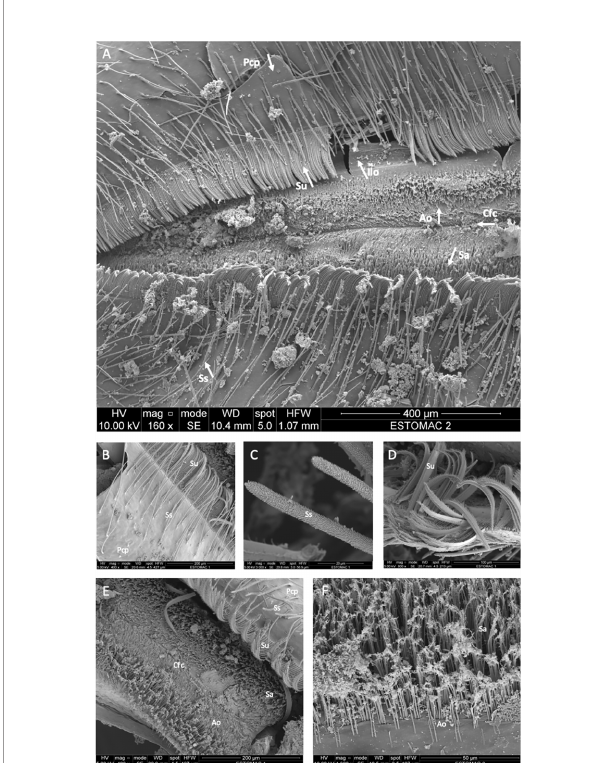
FIGURE 3 | Structure of the cardiac fl oor of a R. exoculata adult observed with scanning electon microscopy. (A) Dorsal view of the cardiac fl oor sieve showing the different ossicles and setae (scale bar = 400 µm). (B) The posterior cardiac plate with simple and serrulate setae (scale bar = 200 µm). (C) Simple setae of the posterior cardiac plate (scale bar = 20 µm). (D) Serrulate setae of the posterior cardiac plate (scale bar = 100 µm). (E) Closer view of the anterior ossicle with its setae, minerals along the surface and the cardiac fl oor crest on the center (scale bar = 200 µm). (F) The different setae of the anterior ossicle (scale bar = 50 µm). Pcp, Posterior cardiac plate; Ss, Simple setae; Su, Serrulate setae; Ilo, Inferior lateral ossicle; Ao, Anterior ossicle; Sa, Setae of the anterior ossicle with minerals; Cfc, cardiac fl oor